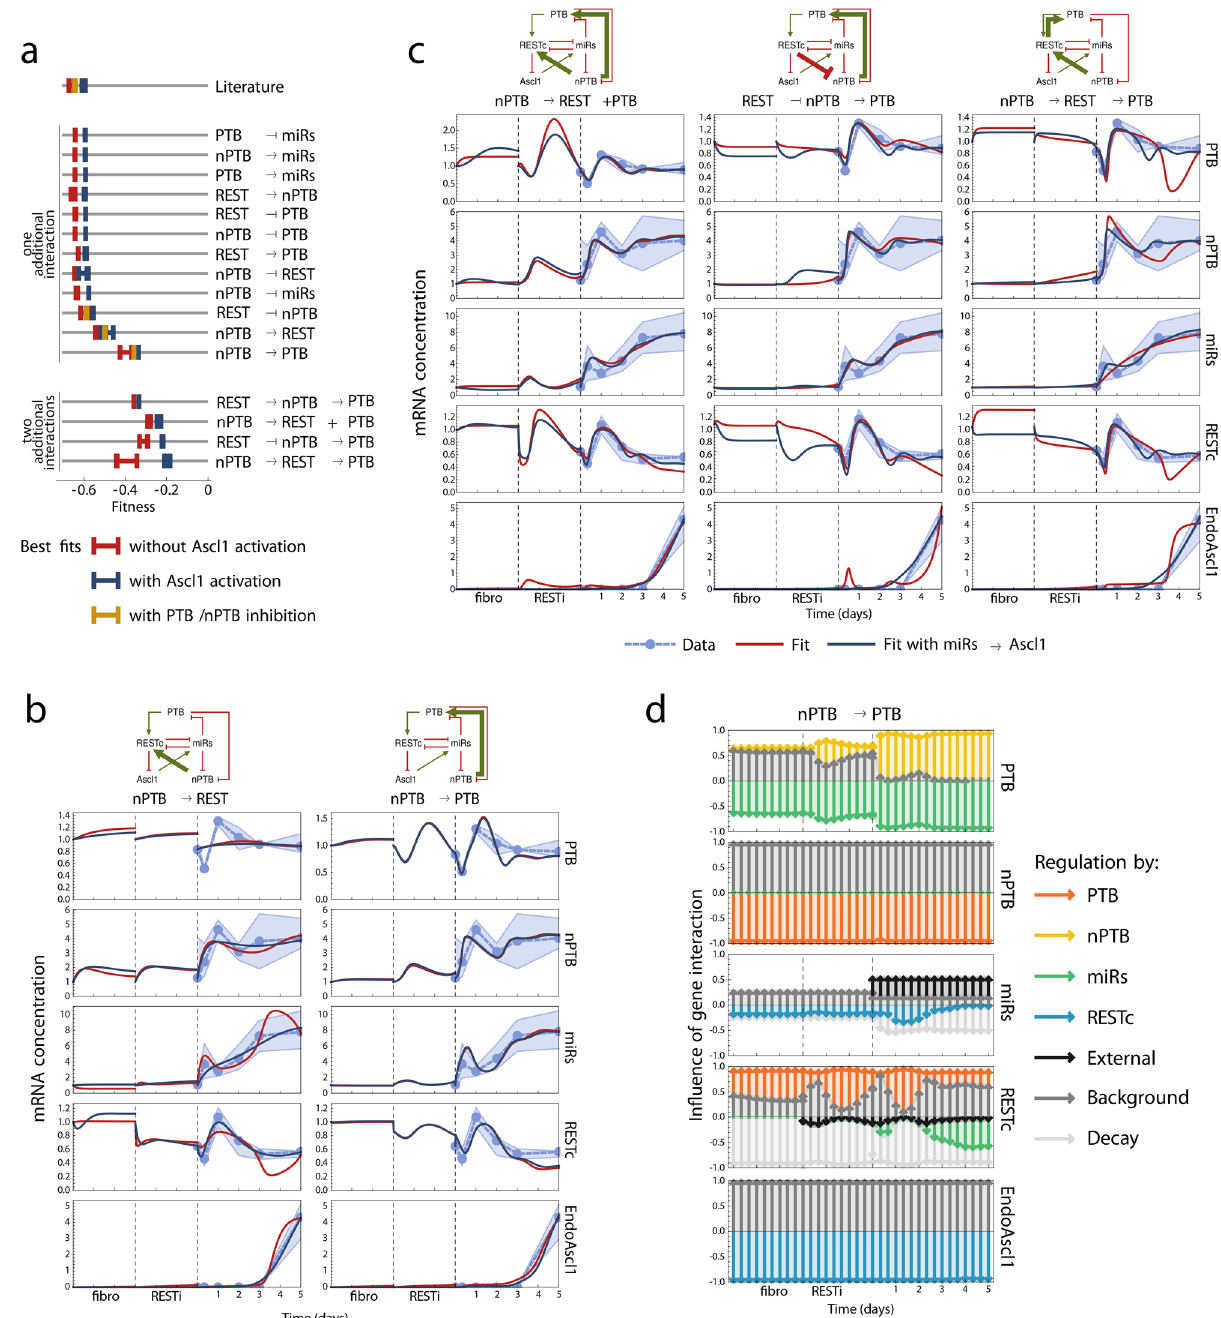
Figure 3. Model performance increases drastically when nPTB activates PTB. ( a ) Model performance as measured by the objective (fitness) function of the optimization procedure, that is, the negative fitting error. Performance of the three best fits is shown. Models are grouped by the hypothetical interaction they have in addition to the literature-based network, where → denotes activation, and ⊣ denotes inhibition. ( b ) The time evolution of the RNA concentrations predicted by the nPTB → REST and nPTB → PTB models. Time scale is divided in the three experimental phases as in Fig. 2b. ( c ) The time evolution of the DNA concentrations in the best models with two additional interactions. ( d ) Dissection of the simulated time evolution in the nPTB → PTB model (see ( b )), decomposing the transcription rates of each factor into the separate contributions of its activators and inhibitors. Activating interactions are represented by arrows pointing upwards from the zero line, inhibiting interactions point downwards. Arrow length indicates relative influence of the regulator. See Methods for an extended description. nPTB and Ascl1 are controlled by changes in inhibition regulation that are too small to see on the figure. The plots were made with Mathematica 11.3.0 (Linux version). https ://www.wolfr am.com/mathe matic